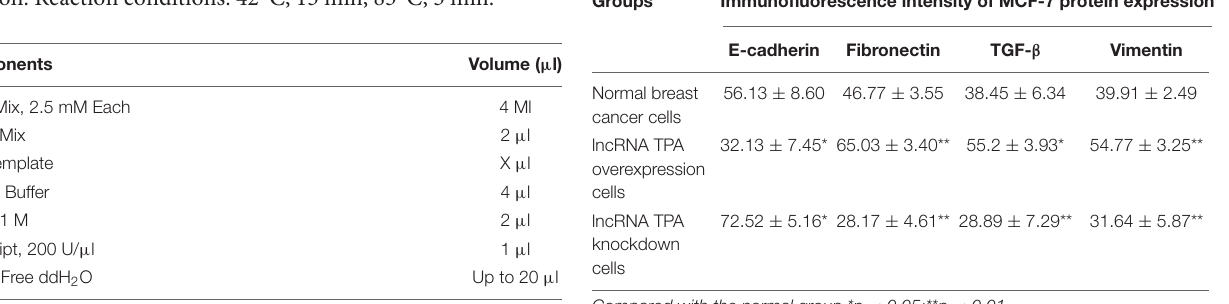
TABLE 3 | The effect of lncRNA TPA overexpression and knockdown on the expression of MCF-7 Vimentin antibody ( χ ± S, n = 3).